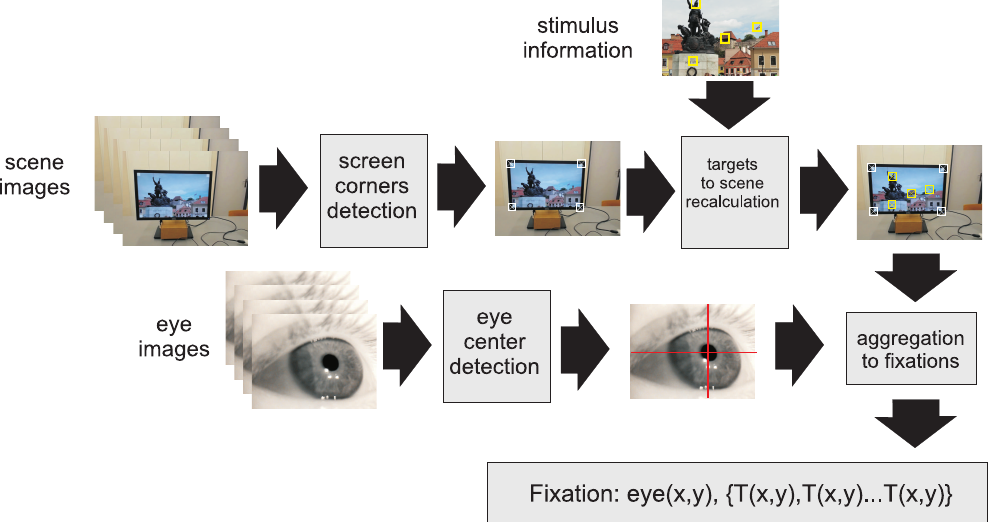
Figure 7. A pipeline of image processing converting scene and eye frames to a list of fixations with eye and targets